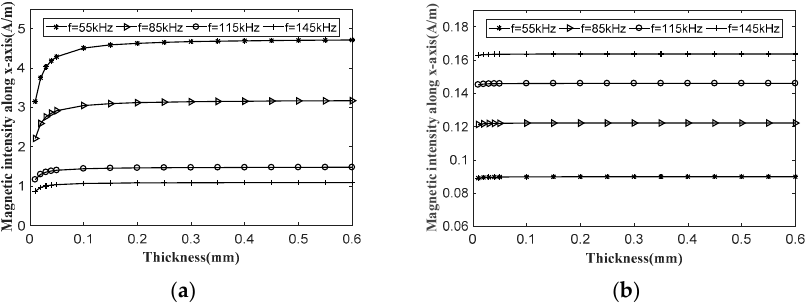
Figure 11. MPTs with the SMPs of different thicknesses: ( a ) The magnetic field intensity in Line 1 in wave generation; and ( b ) the magnetic field intensity in Line 2 in wave detection.